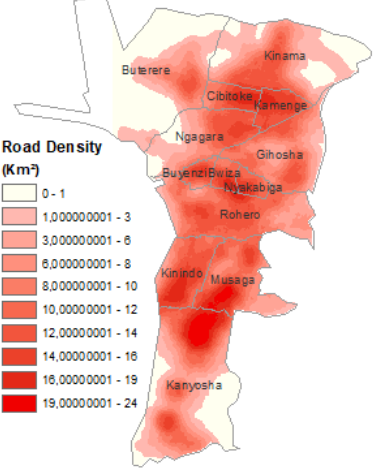
Figure 8. Road density in Km per Km²